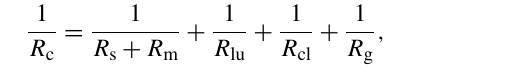
Figure 1. Diagram of the GC-YIBs global carbon-chemistry model. Processes with red font are implemented in this study. Processes in the blue dashed box will be developed in the